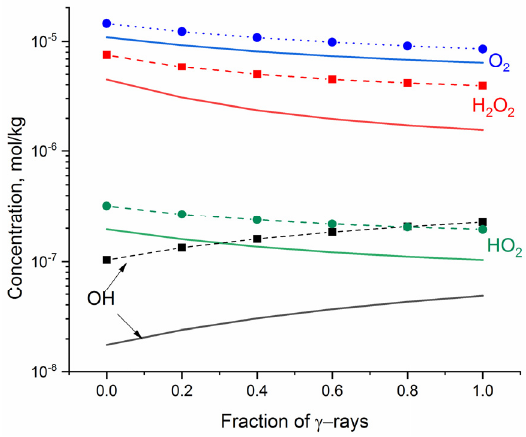
Figure 1. Concentration profiles of the radiolytic species calculated for neutral deaerated water exposed to ( a ) gamma and ( b ) fast neutron radiation at 300 °C and dose rate 1 kGy·s − 1 .